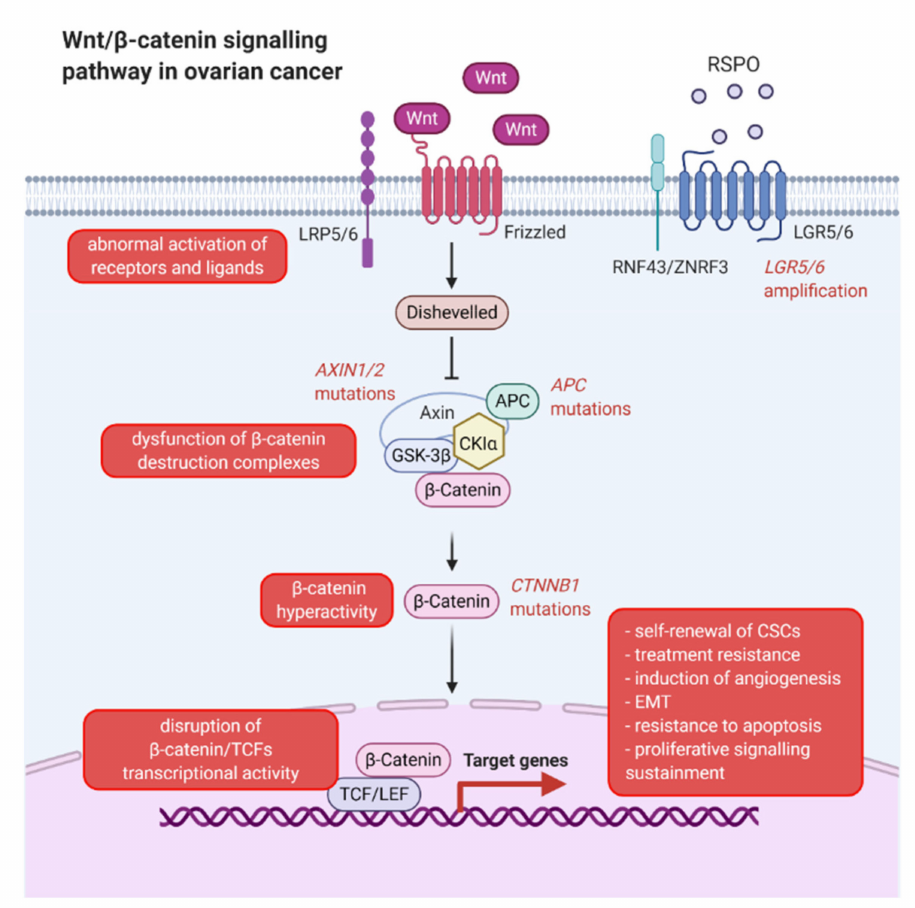
Figure 3. Wnt/ β -catenin signaling pathway in ovarian cancer. Abbreviations: APC—adenomatosis polyposis coli; CKI α — casein kinase 1 α ; CSC—cancer stem cell; EMT—epithelial-to-mesenchymal transition; GSK-3 β —glycogen synthase kinase 3 β ; LGR5/6—leucine-rich repeat-containing G-protein coupled receptors 5/6; LRP5/6—low-density-lipoprotein-related proteins 5/6; RNF43/ZNRF3—RING finger protein 43/Zinc/Ring finger protein 3; RSPO—R-spondin; TCF/LEF-T—cell factor/lymphoid enhancer-binding factor proteins; Wnt—An acronym standing for homologous wingless (wg) and Int-1 (created with